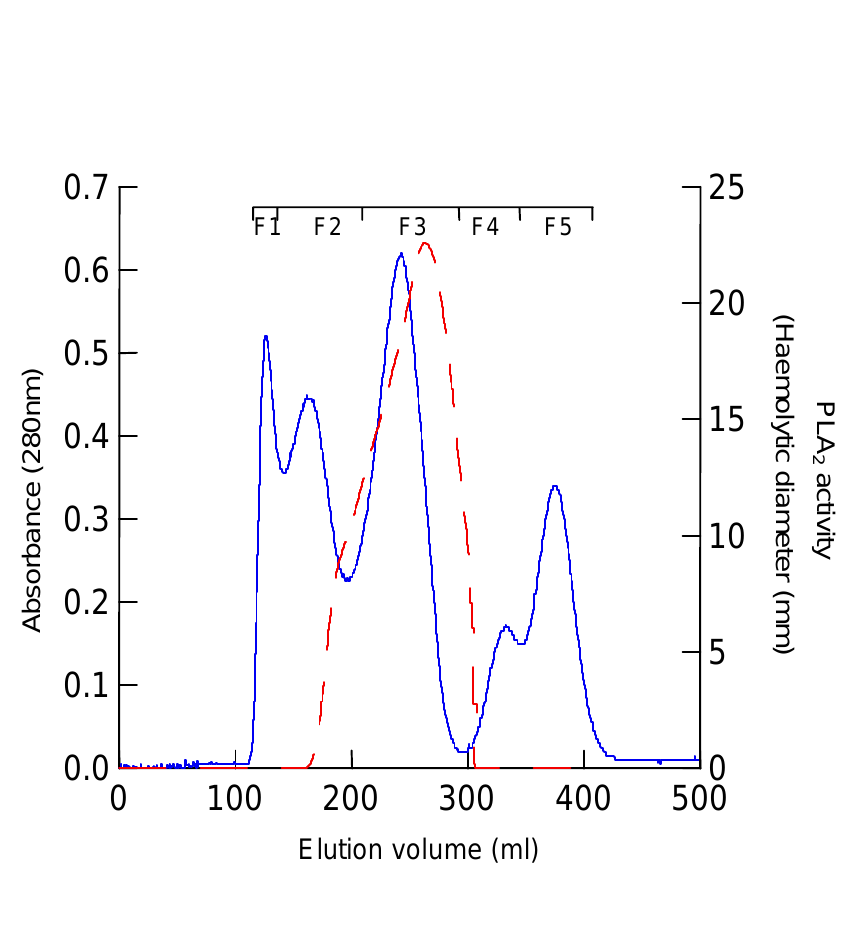
Figure 1. Sephadex G-75 Column Chromatography of B. asper venom. 100 mg dry weight (66 mg of protein) of B. asper venom was applied to a Sephadex G-75 column (2.6 x 71.5 cm) equilibrated with 5% of acetic acid. The elution was carried out to 60 ml/h with the same solvent and collection fractions of 10 ml. The absorbance was monitored activity was assayed by indirect haemolysis ( ) using egg yolk in at 280 nm ( ), and PLA 2 saline solution